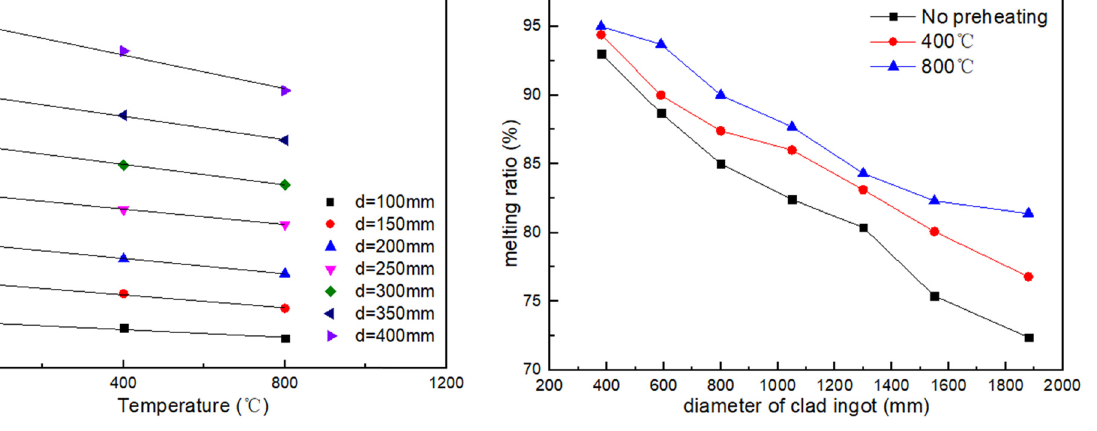
Figure 9: Variation of cladding thickness with preheating temperature.